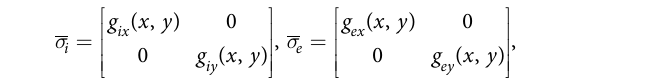
are used. In most locations, g ex , g ey , g ix , and g iy are taken to be 0.8, 2.0 0.2, and 2.0 mS/cm, respectively. The aniso- tropy ratios are the same as the nominal values reported in 58 . As in 59 and 60 , g ix is set to zero in some locations to